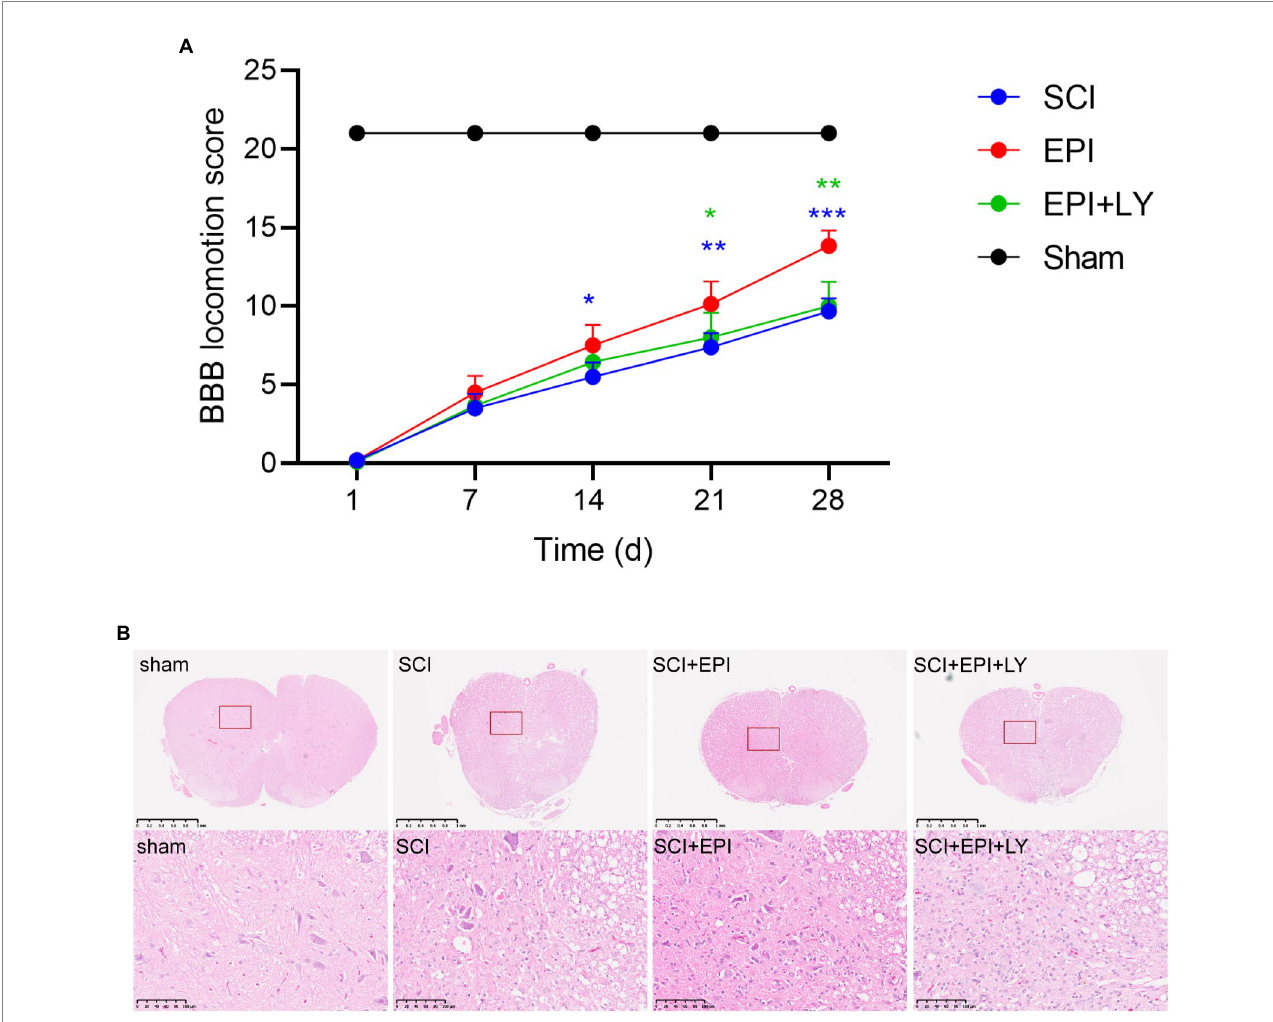
FIGURE 7 EPI enhances behavioral performance and tissue repair in SCI rats (N = 3 per group). (A) Use BBB score to evaluate the recovery of motor function in sham group, SCI group, SCI + EPI group, and SCI + EPI + LY group, respectively, in 3, 7, 14, 21, 28 days (N = 10 per group). (B) HE-stained transverse sections of spinal cords from sham group, SCI group, SCI + EPI group, and SCI + EPI + LY group (N = 3 per group). * means p < 0.05, ** means p < 0.01, and *** means p <